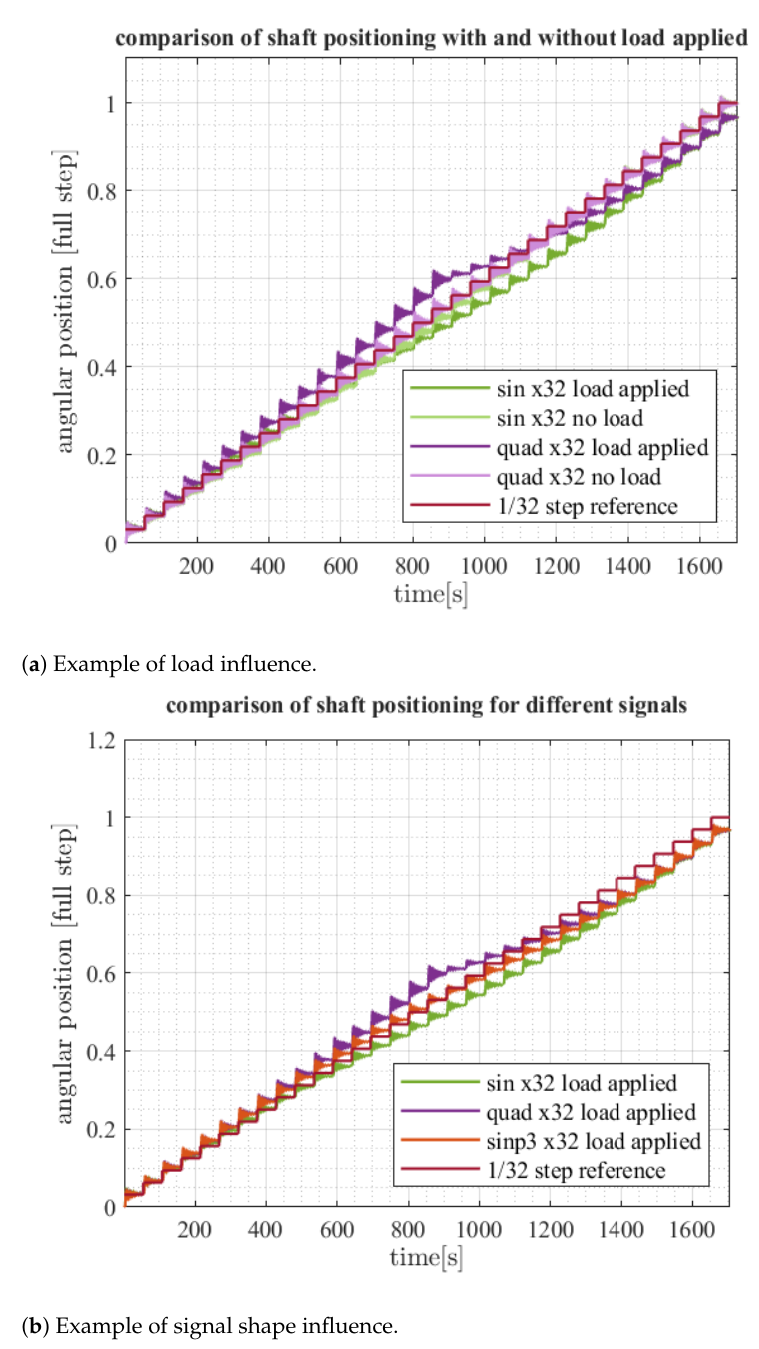
Figure 24. Influence of load and signal shape on shaft position over one full